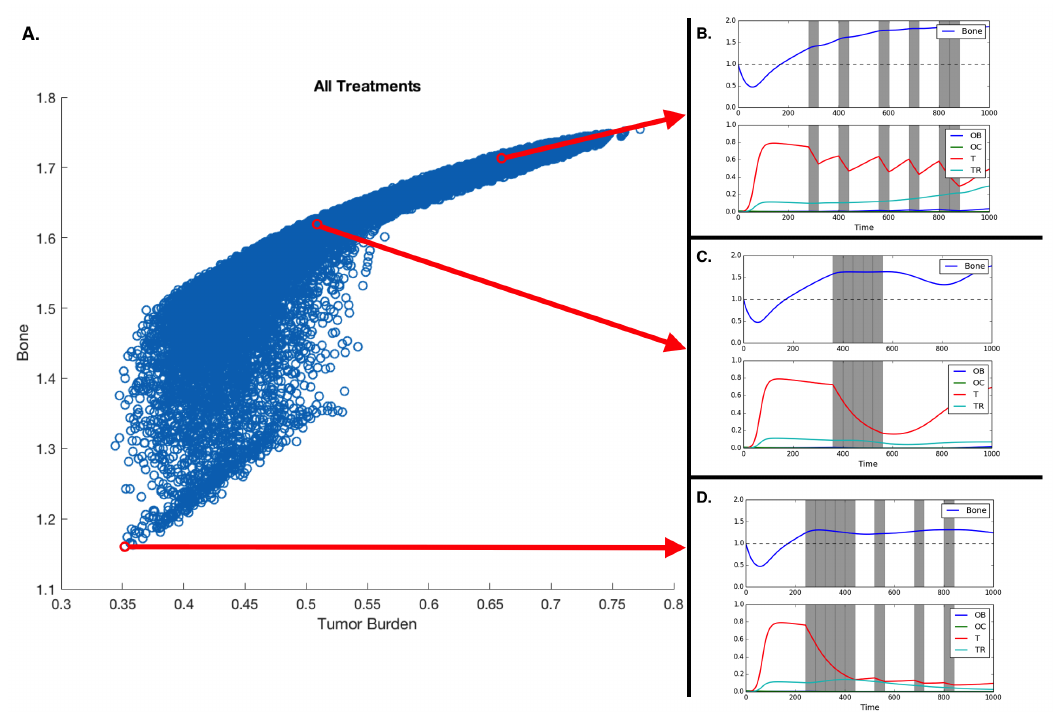
Figure 4. Treatment and treatment holiday combinations. Better treatments are those that reduce tumor burden and extra pathological bone. ( A ) All potential treatments over 16 40-timestep periods, plotted with respect to average tumor burden and average bone size. ( B , C , D ) Treatment regiments showing an example of a fractionated treatment ( B ), continuous block treatment ( C ), and a fractionated follow-up regiment ( D ). Assuming initial densities of the different population as follows: ρ OB ( 0 ) = 0.001, ( 0 ) = 0.0, and B ( 0 ) = ρ OC ( 0 ) = 0.01, ρ T ( 0 ) = ρ T R